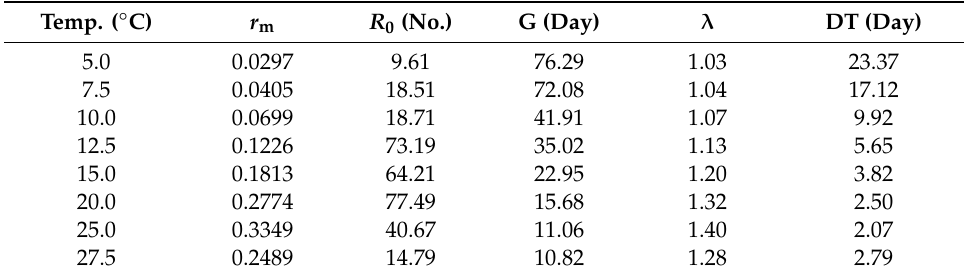
Table 8. Life table parameters of A. solani at di ff erent constant temperatures using traditional age-specific life table